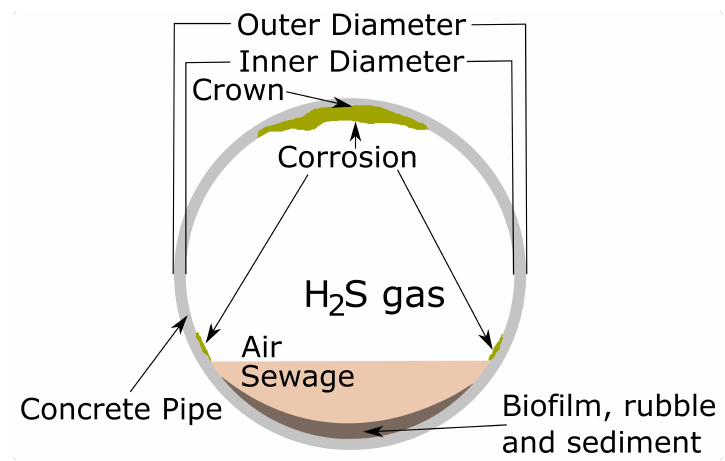
Figure 1. Diagram of the corroded sewer pipe